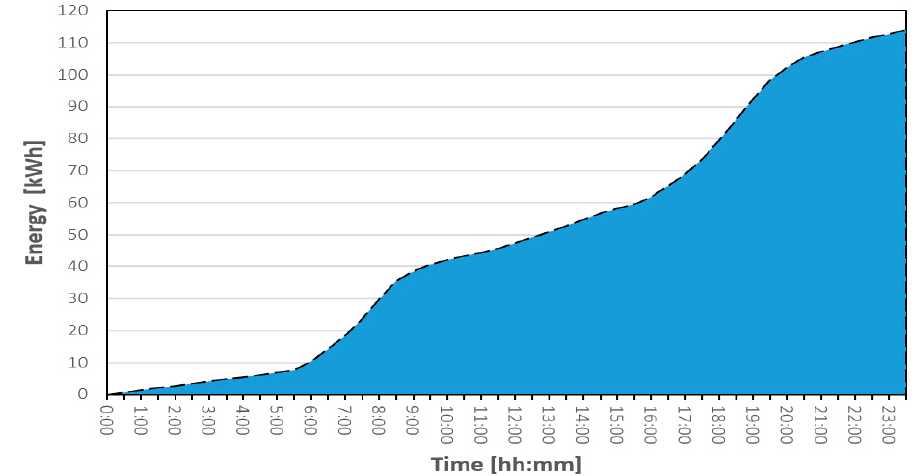
Figure 10. Overall daily energy absorption of the car park (without Electric Vehicle Supply Equipment—EVSE).